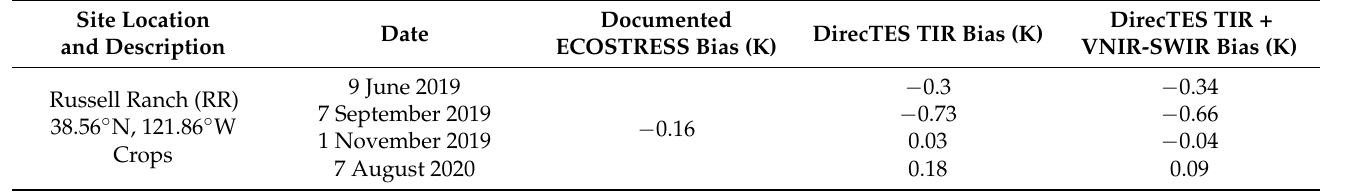
Table 4. Retrieved bias for L2 ECOSTRESS LST product and for DirecTES TIR and DirecTES TIR + VNIR-SWIR LST on the 5 selected sites. The documented ECOSTRESS bias has been adapted from